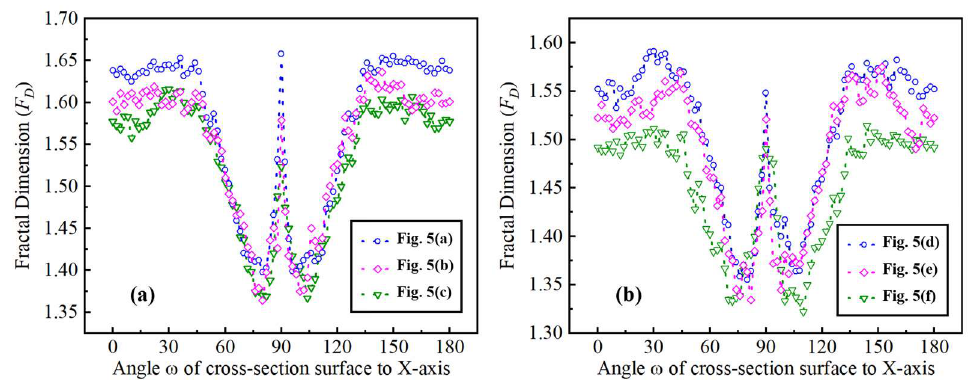
Figure 9. The 2D fractal dimension at various included angles to the x -axis on the different machined KDP surfaces, as shown in Figure 5.